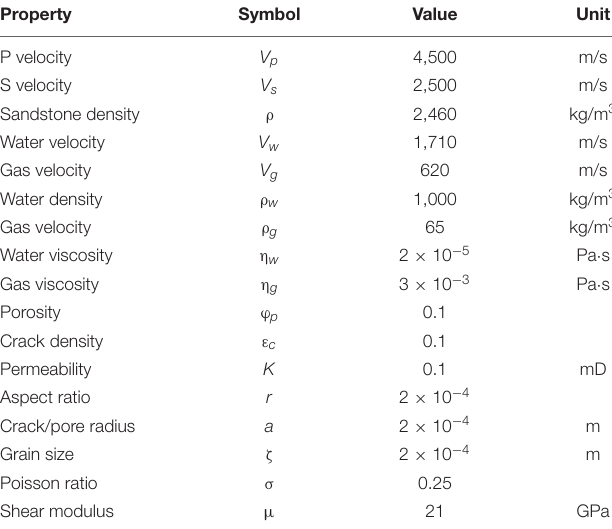
TABLE 1 | Properties of tight gas